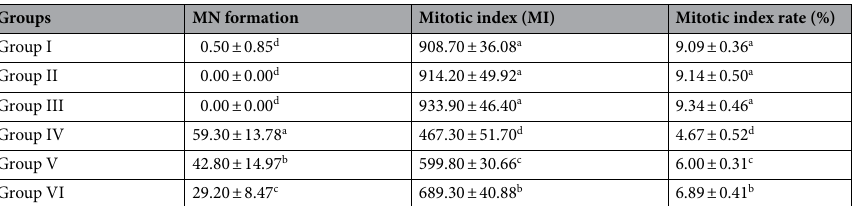
Table 4. Effects of pendimethalin on MN formation and Mitotic index (MI) and protective role of curcumin. Group I: tap water (control), Group II: 5 mg/L curcumin, Group III: 10 mg/L curcumin, Group IV: 12 mg/L pendimethalin, Group V: 12 mg/L pendimethalin + 5 mg/L curcumin, Group VI: 12 mg/L pendimethalin + 10 mg/L curcumin. Data are shown as mean ± standard deviation (SD). The averages shown with different letters in the same column are statistically significant ( P <